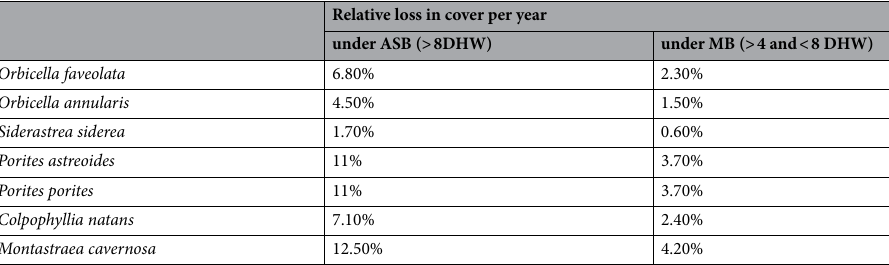
Table 2. Percent cover reduction (relative to the percentage cover of the previous year) under annual severe bleaching (ASB, DHW > 8) and modest bleaching (MB, 4 < DHW > 8) for the eight main species found at Cheeca Rocks (based on Gintert et al ., 2018).